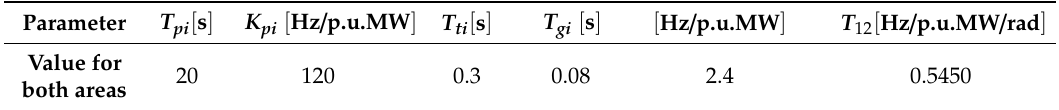
Table 2. Parameters of load frequency control scheme.